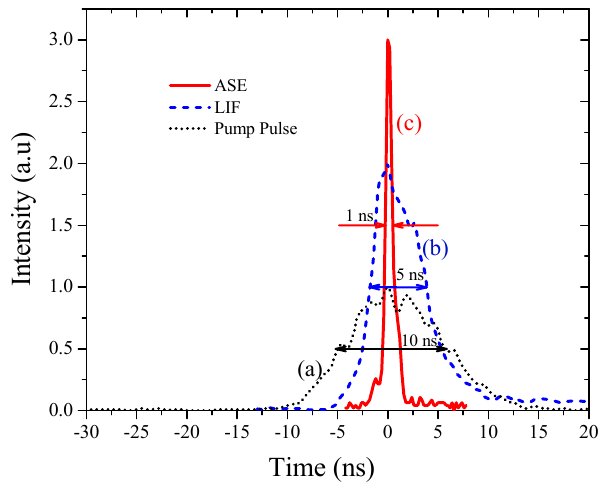
Figure 6. Temporal profile of ASE, LIF (PFO-co-pX), and pump pulse.